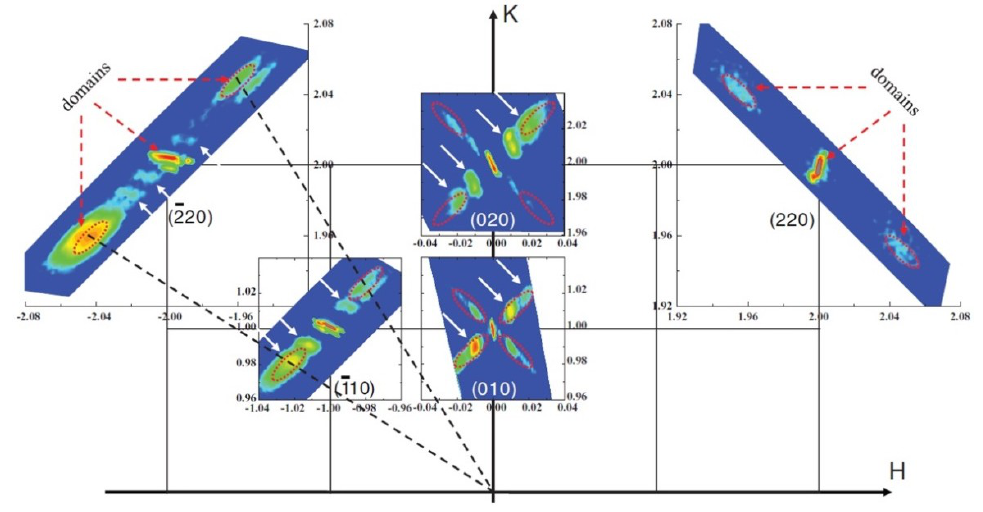
Figure 4. In-plane reciprocal space mappings (RSMs) of 10-nm thick BFO film grown on LaAlO (LAO). Red arrows and red circles denote the reflections of domain variants while 3 white arrows denote periodic modulation. (Reprinted with permission from [36].